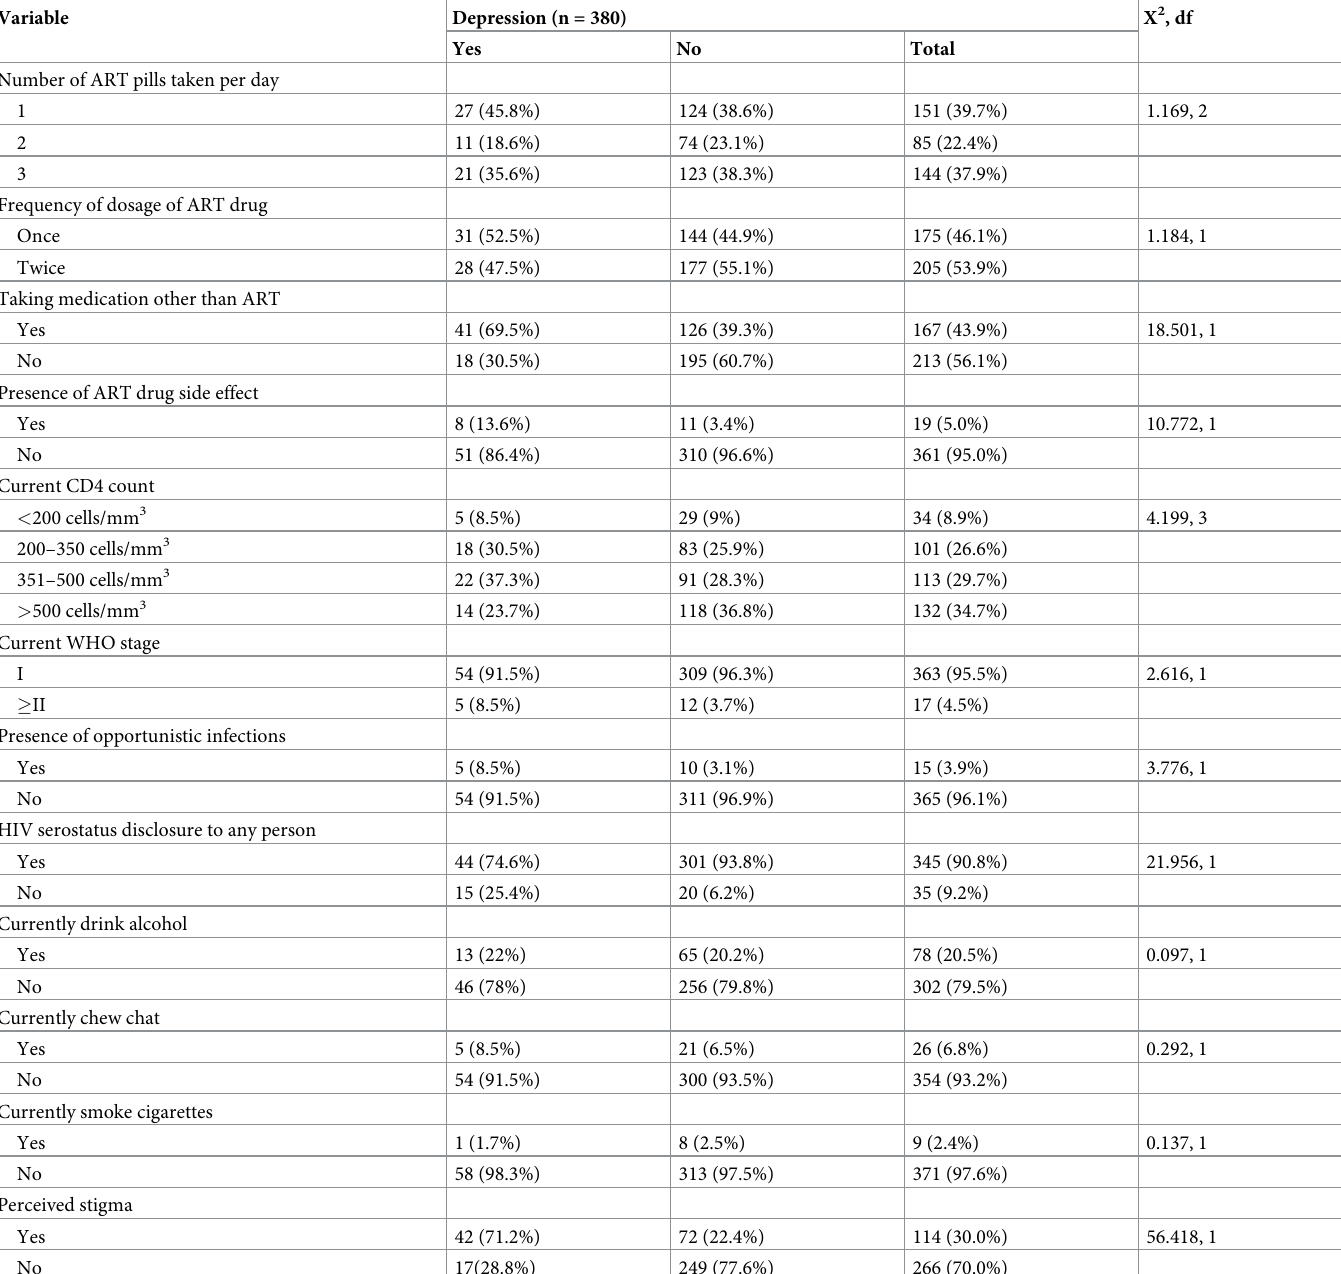
Table 2. Clinical, psycho-social, and behavioral characteristics of HIV positive patients attending public health facilities of Dessie town, Northeast Ethiopia, 2019. Variable Depression (n = 380) X 2 ,